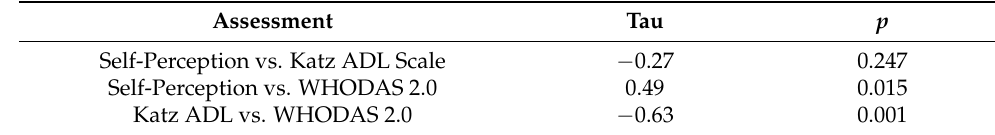
Table 4. Correlation between assessment scales using Kendall’s Tau among patients discharged from hospital at 28-days post-injury (N =